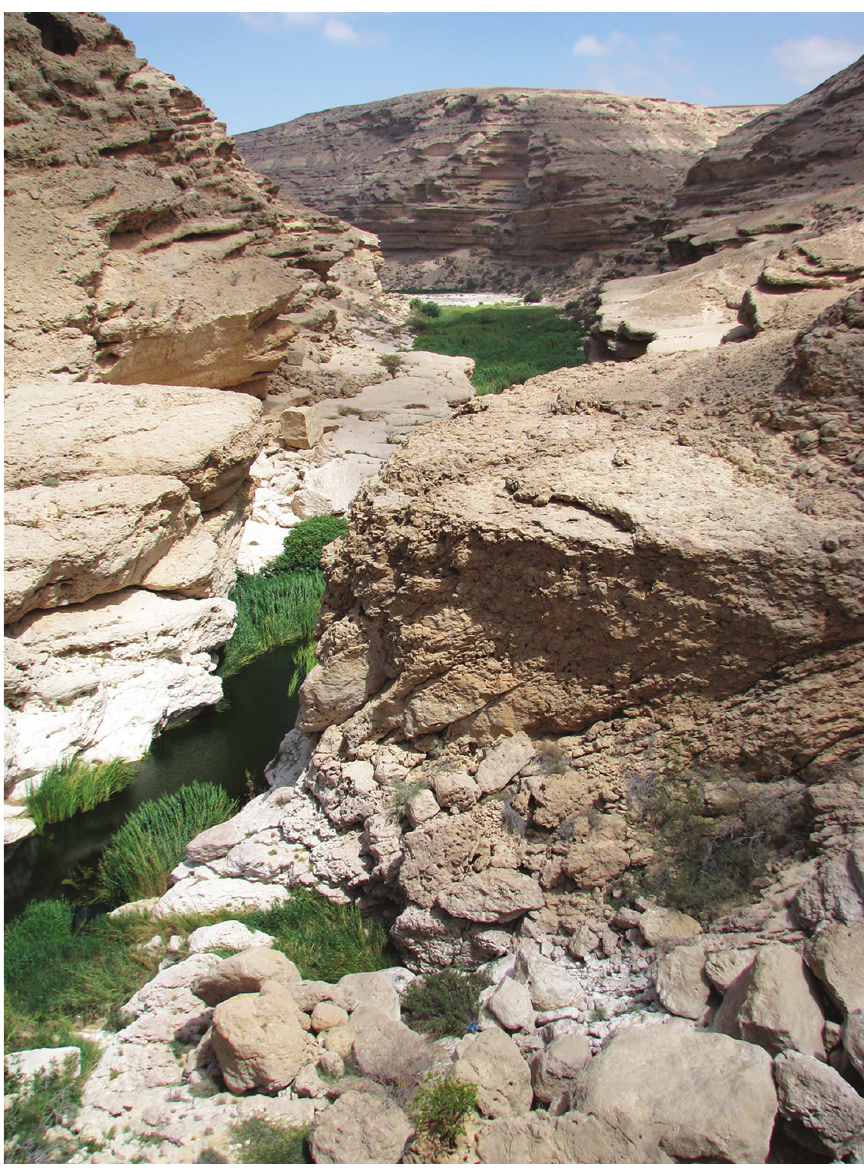
Figure 18. The habitat at Wadi Ayun (Dhofar, Oman) where Sphodromerus carapezzanus sp. n. was col- lected (photo by A.